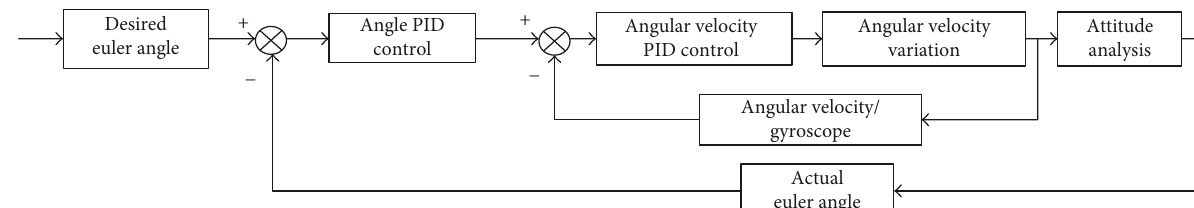
Figure 9: Attitude controller.